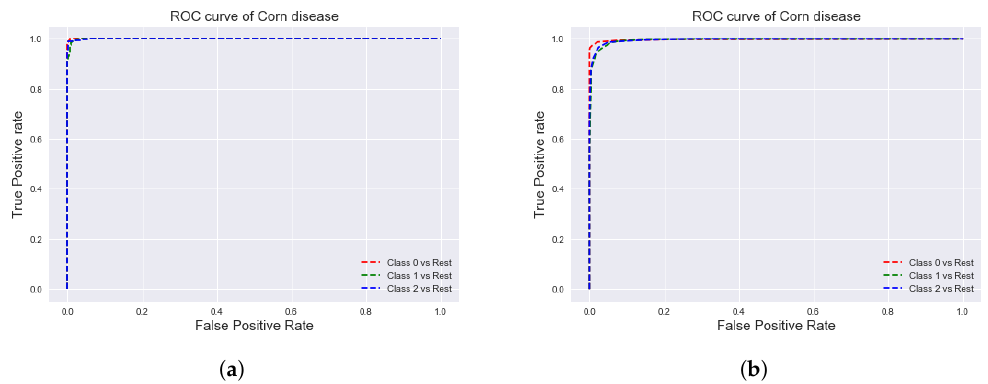
Figure 8. AUC-ROC curve of Potato diseases ( a ) shallow VGG with Xgboost ( b ) shallow VGG with RF.